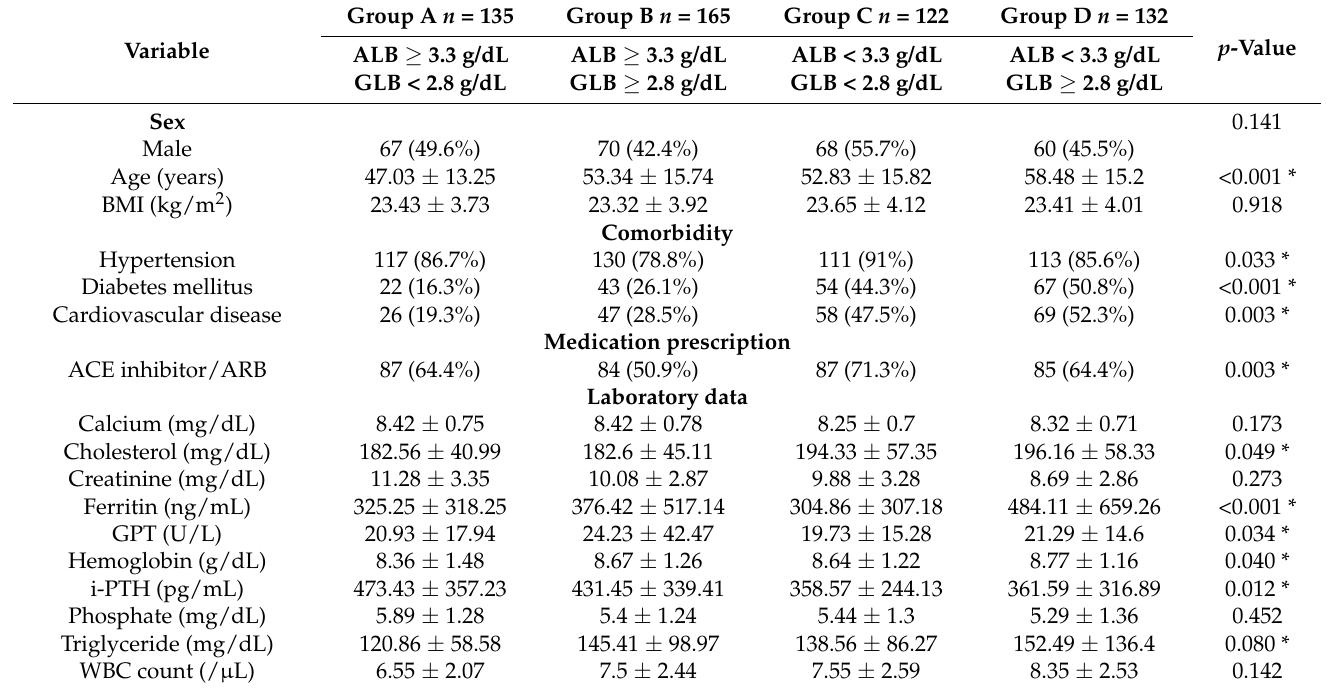
Table 1. Baseline characteristics of 554 patients stratified by the median values of albumin and